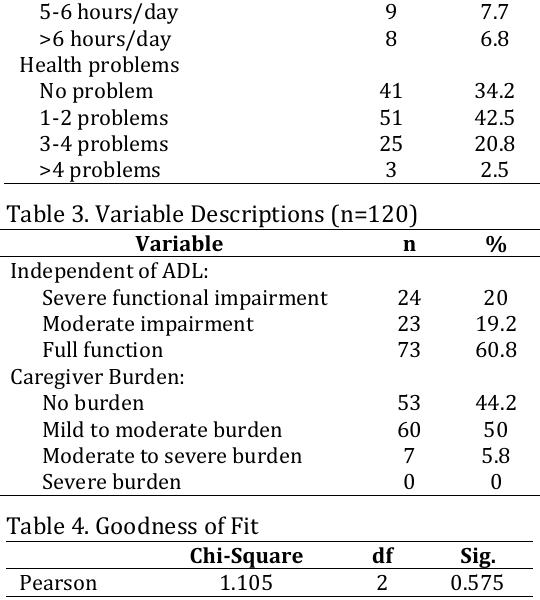
Table 1. Characteristics of the Stroke Patients